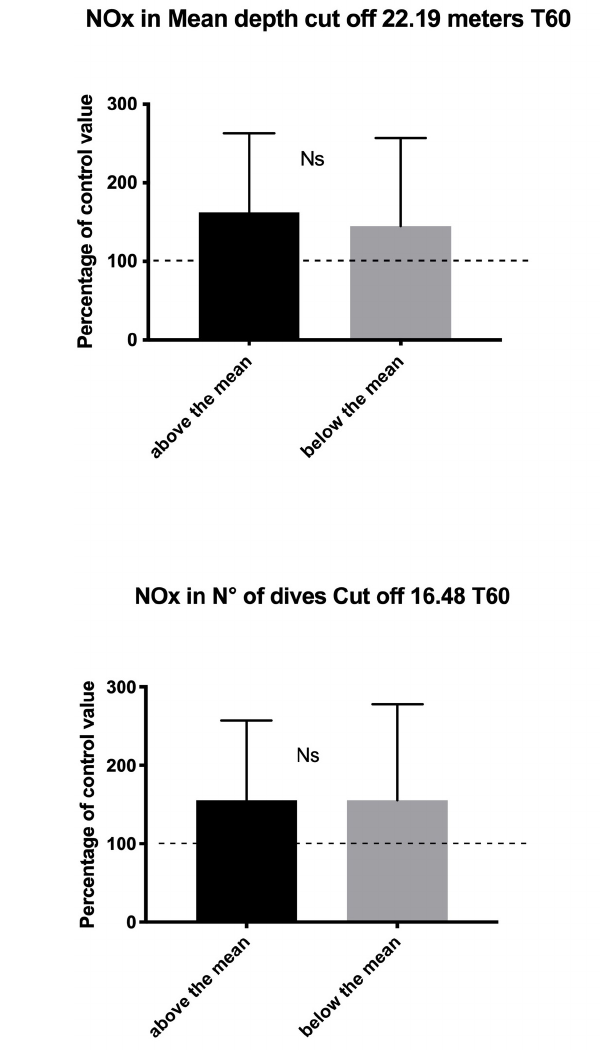
Frontiers in Physiology |